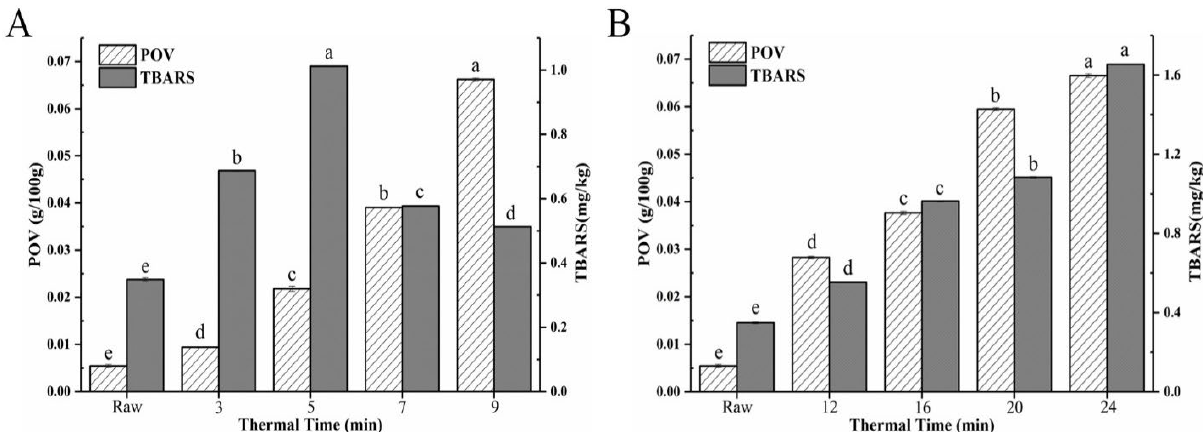
Figure 2. ( A ) POV value and TBARs of DF hairtail fillets. ( B ) POV value and TBARs of AF hairtail fillets. Different letters within each substrate indicate significant difference ( p < 0.05) .